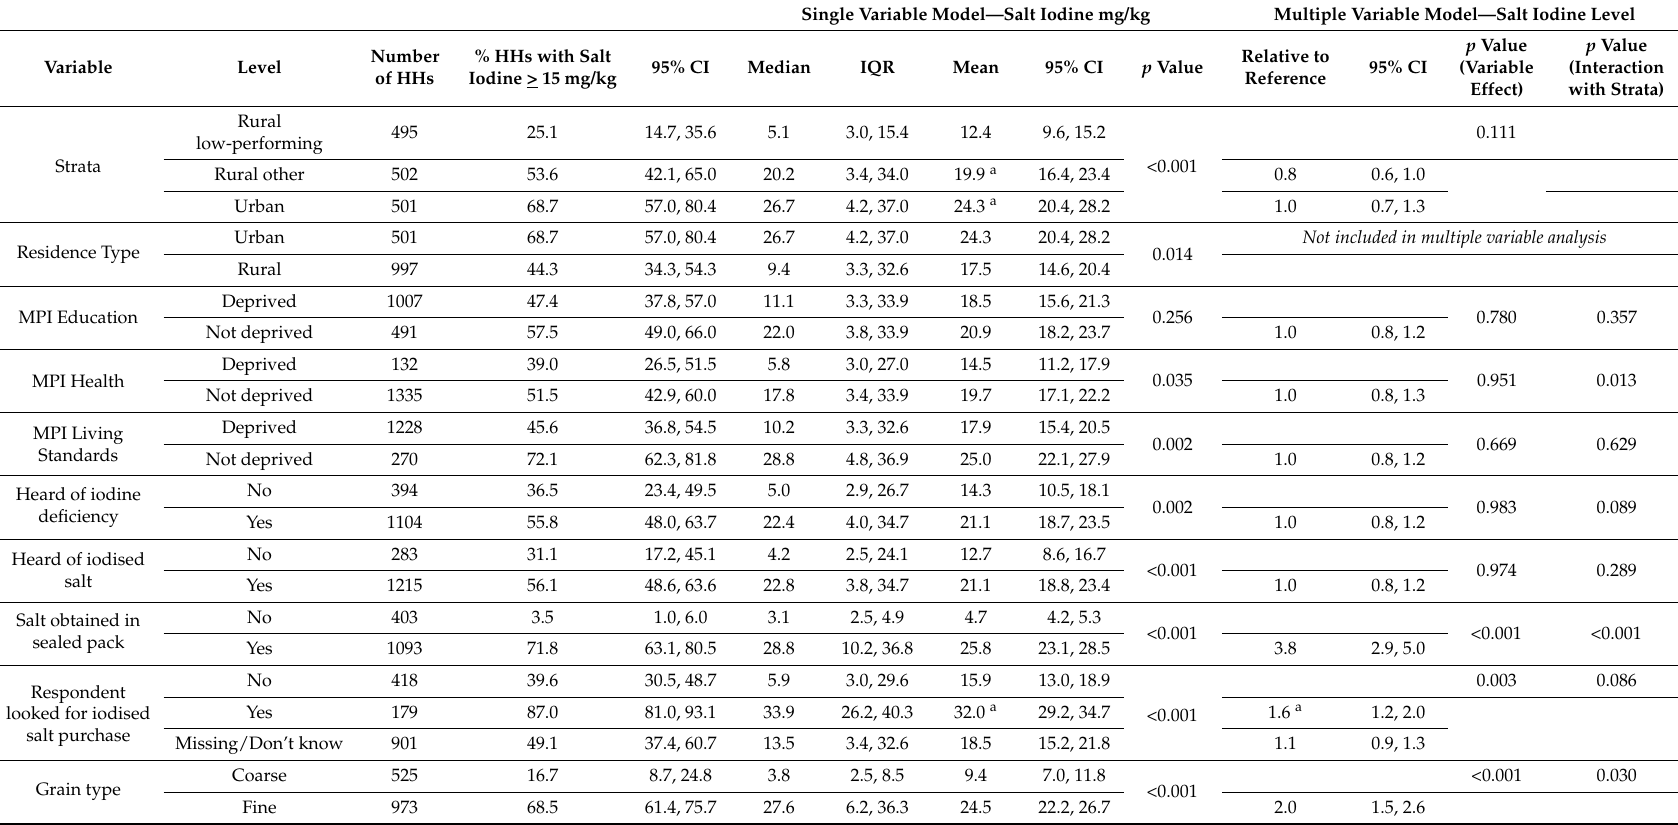
Table 2. Regression analyses of factors associated with household salt iodine